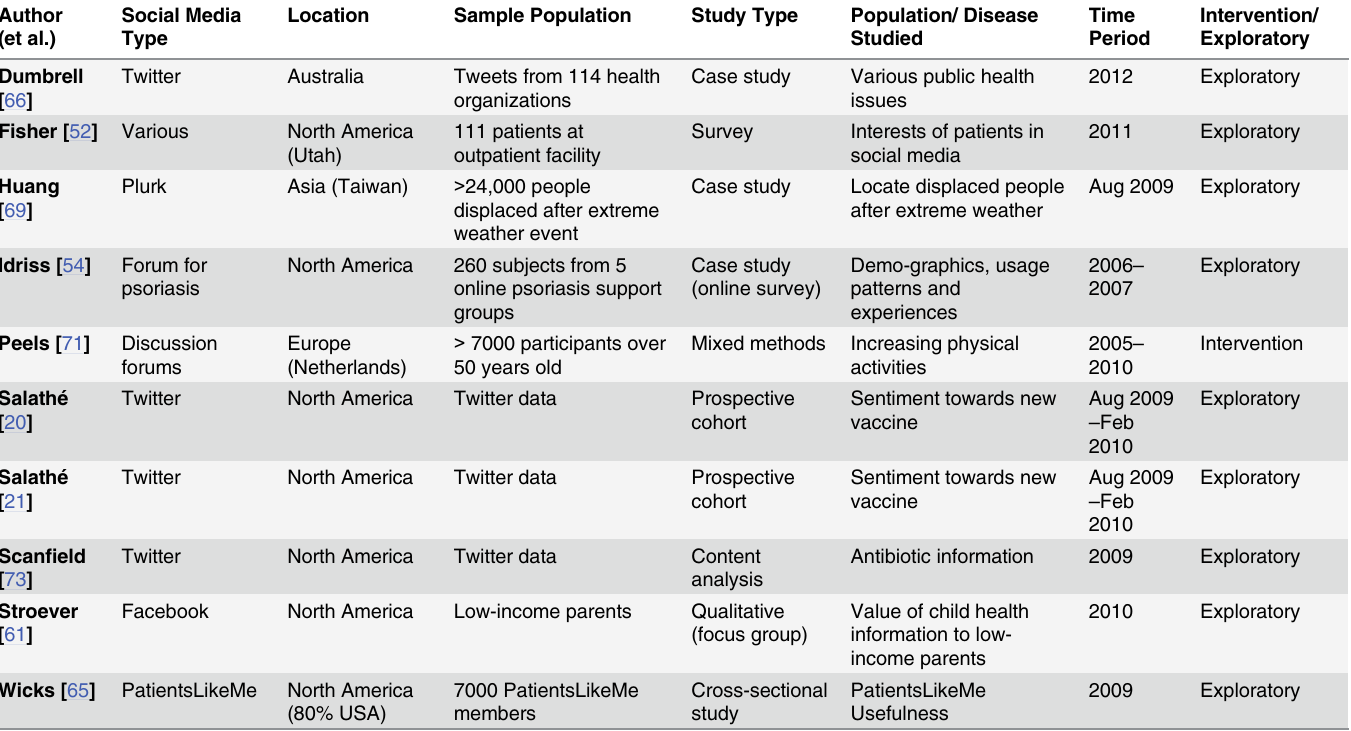
Table 11. Characteristics of 10 “ other ” topic studies addressing research question 2 a